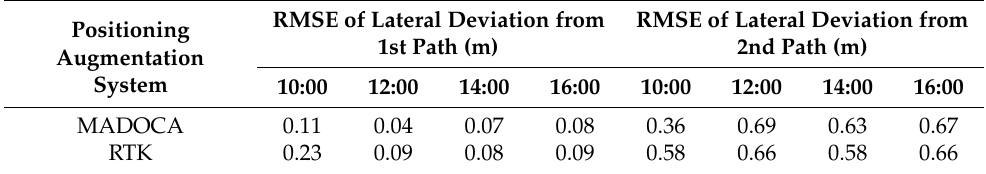
Table 6. Results from robot combine harvester controlled by